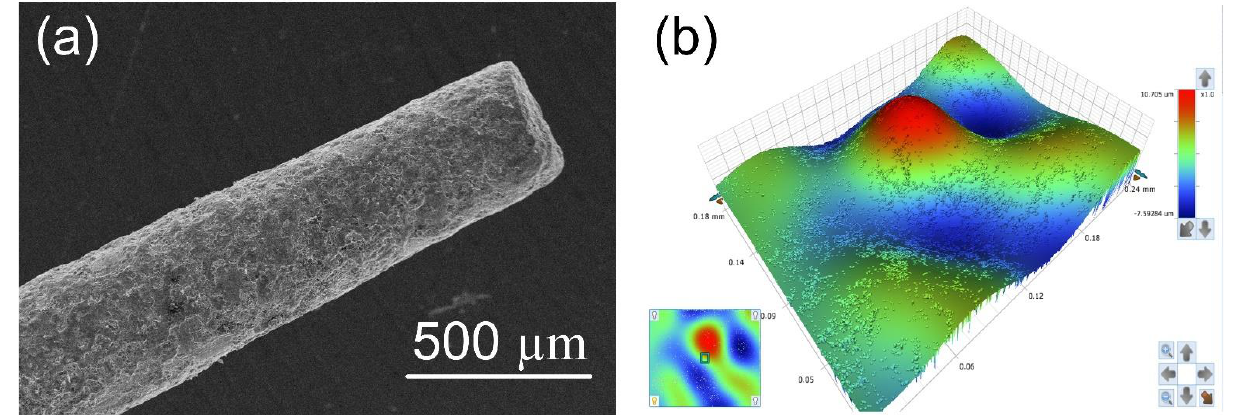
Figure 5. SEM image of ( a ) rough tool and ( b ) topographic view rough tool surface. During experimentation, the value of current was varied from 1 A to 4 A, while the other parameters were kept constant (Lift = 2; pulse on:pulse off = 170:67 μ s; gap voltage = 60 V; tool rotation rate = 500 rpm). The constant value of process parameters was selected based on the pilot experiments, where a current was founded as one of the most significant parameters to effect the surface roughness value [11]. In order to get the repeatable conditions, each experiment was performed three times at individual parametric settings, the topo graphs of fabricated rough (rough) tools are depicted in Figure 6.